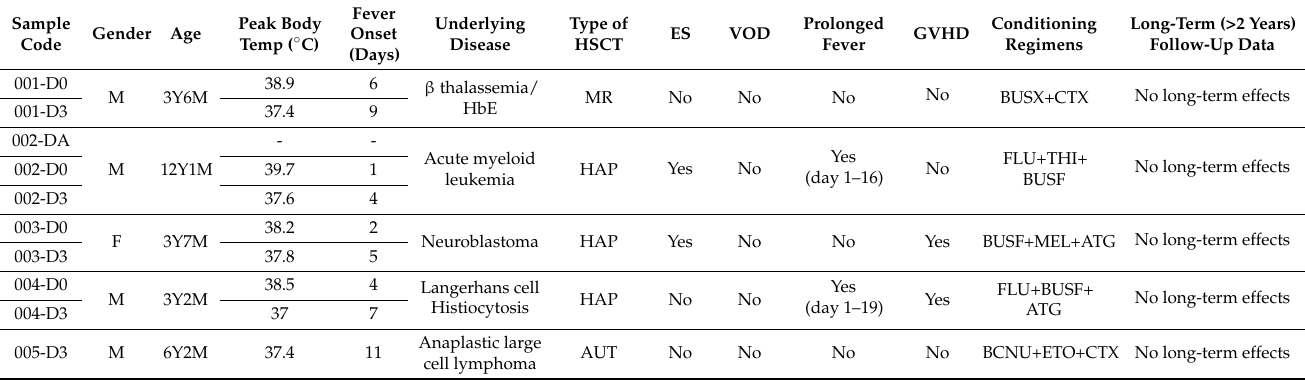
Table 1. Summary of the associated clinical data of the samples sequenced in this